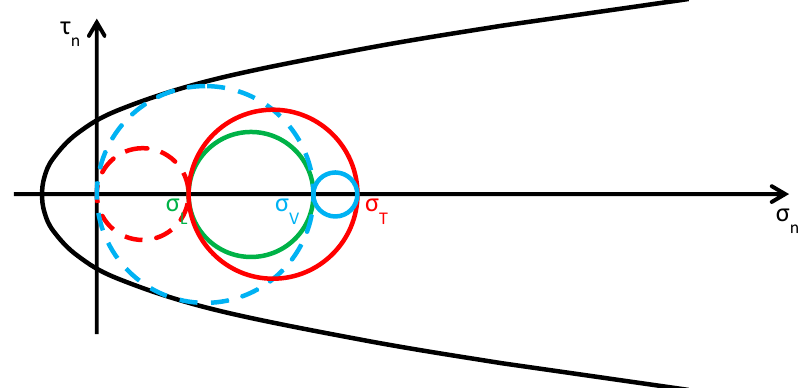
Figure 17. Stress analysis in the plane of Mohr/Coulomb after retrofitting, for σ L < σ T ≤ σ V (Mohr’s circles before retrofitting in dashed lines, for comparison).